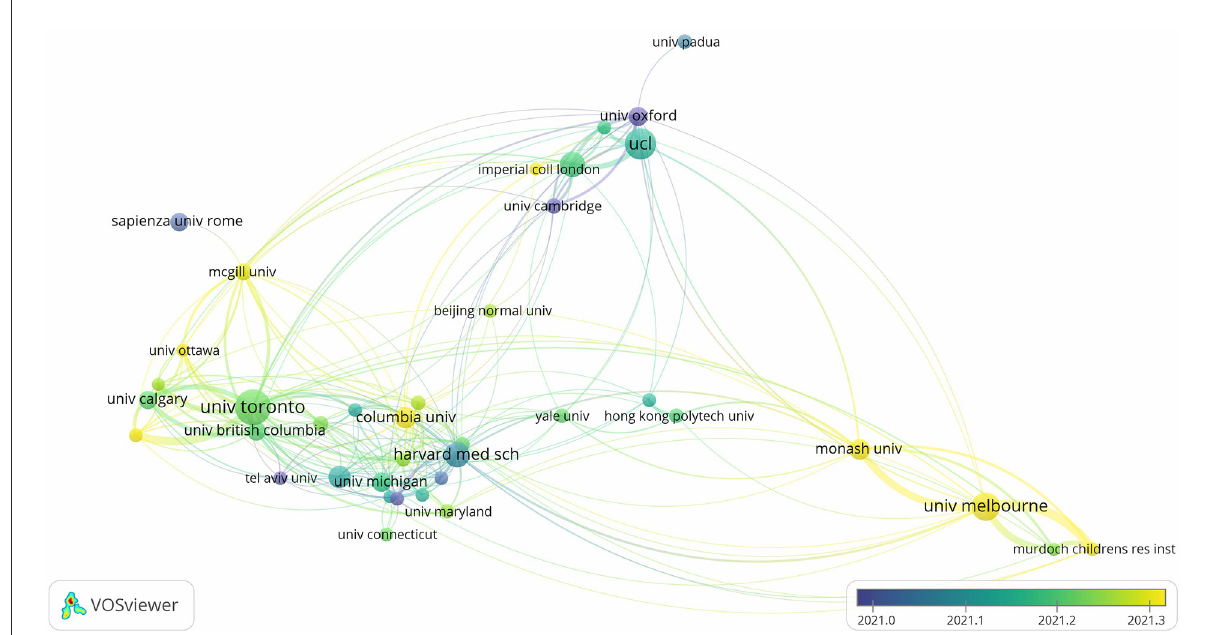
FIGURE3 Visualization map of cooperation network between institutions, based on the publication-weights and average publication year scores.